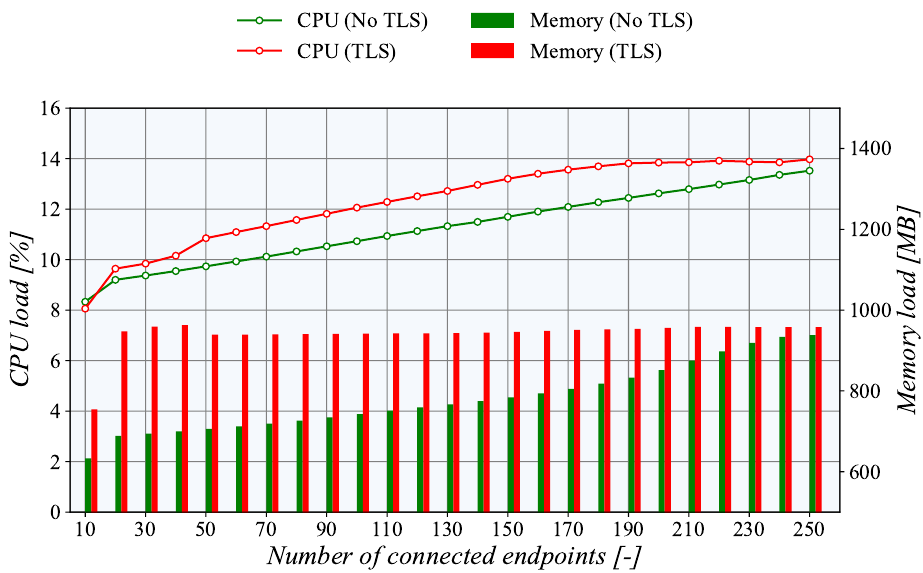
Figure 12. Utilization of system resources on the generator side in a PUSH scenario.